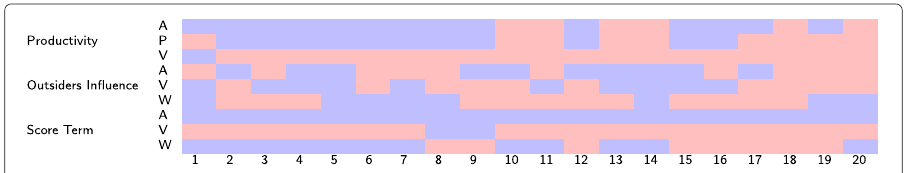
Fig. 4 Features considered on the top 20 OTARIOS variants on the NDCG metric. The rows represent different features and the columns the variants that ranked at position n . The blue colour in a column indicates that the feature is considered on the variant, while the red colour indicates its absence